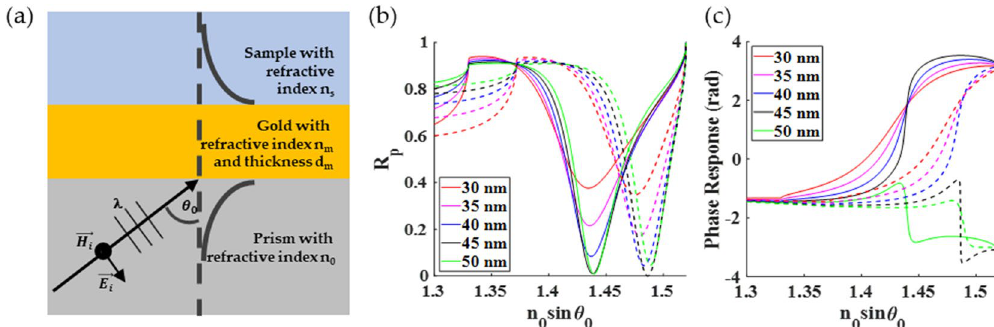
Figure 1. ( a ) Schematic diagram of Kretschmann configuration, ( b ) simulated reflectance for SPR gold sensors with thicknesses d m of 30 nm, 35 nm, 40 nm, 45 nm, and 50 nm, and ( c ) phase responses in rad of the SPR sensors, when they were illuminated by p-polarized light at 633 nm. Solid curves for sample refractive index of 1.33 (water) and dashed curves for sample refractive index of 1.37 (liquid bovine serum albumin protein) 11